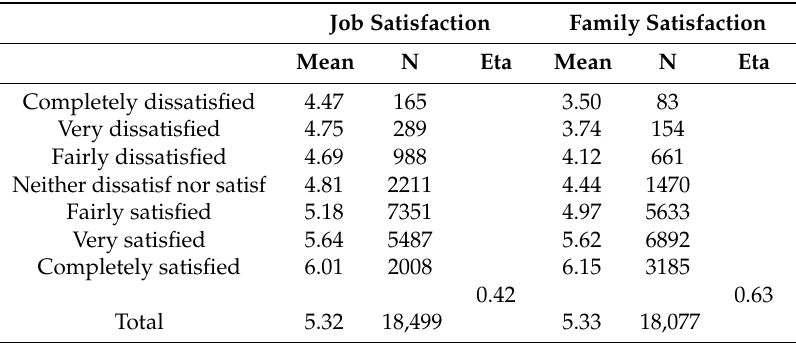
Table 2. Job satisfaction and family satisfaction by happiness. Job